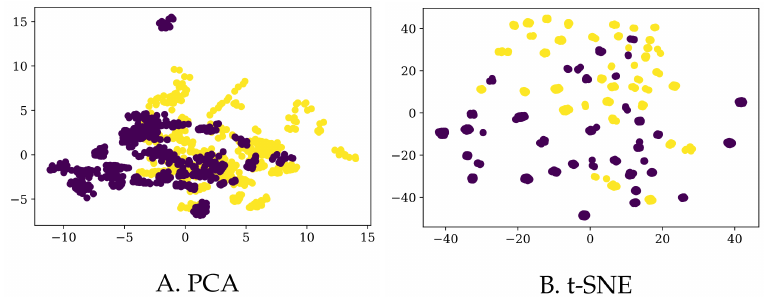
Figure 4. A 2D representation of the BigD dataset (1202 points in R 126 ); in yellow, positive examples (PD patients), in purple, negative examples (participants in the HC group).